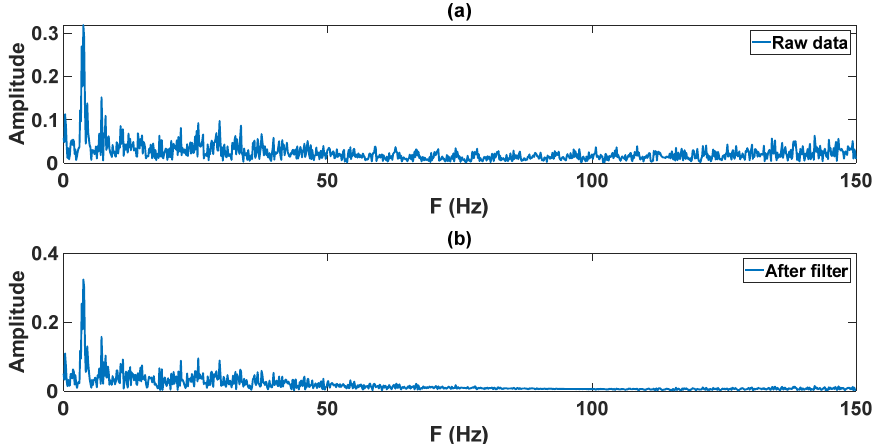
Figure 13. Spectrum analysis of the EMG signals. ( a ) presents the spectrum distribution of the EMG signals captured. ( b ) displays the spectrum distribution of the EMG signals after moving average The proposed system controls the actions of the VR games by making a fist. When an EMG peak is detected, the output is 1; otherwise, the peak detection is 0. The experiment data are the same as the data for the moving average. The ASM S & C algorithm is used to determine the initial_value first, which is then used to find the initial_slope_maxi , as well as